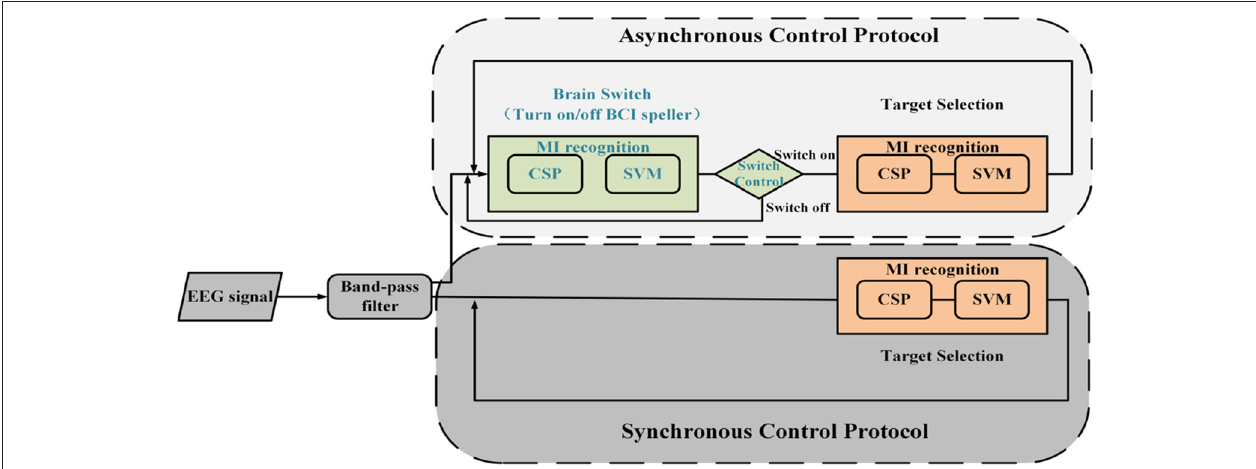
FIGURE 2 | Framework for asynchronous and synchronous control protocols. First, EEG signals are band pass filtered at 5–30Hz for removing background noise. Then, common spatial pattern (CSP) and support vector machine (SVM) are combined to discriminate three-class (left hand, right hand, foot) MI patterns. For asynchronous control protocol, a brain switch is used for turn on/off this BCI speller by MI tasks.